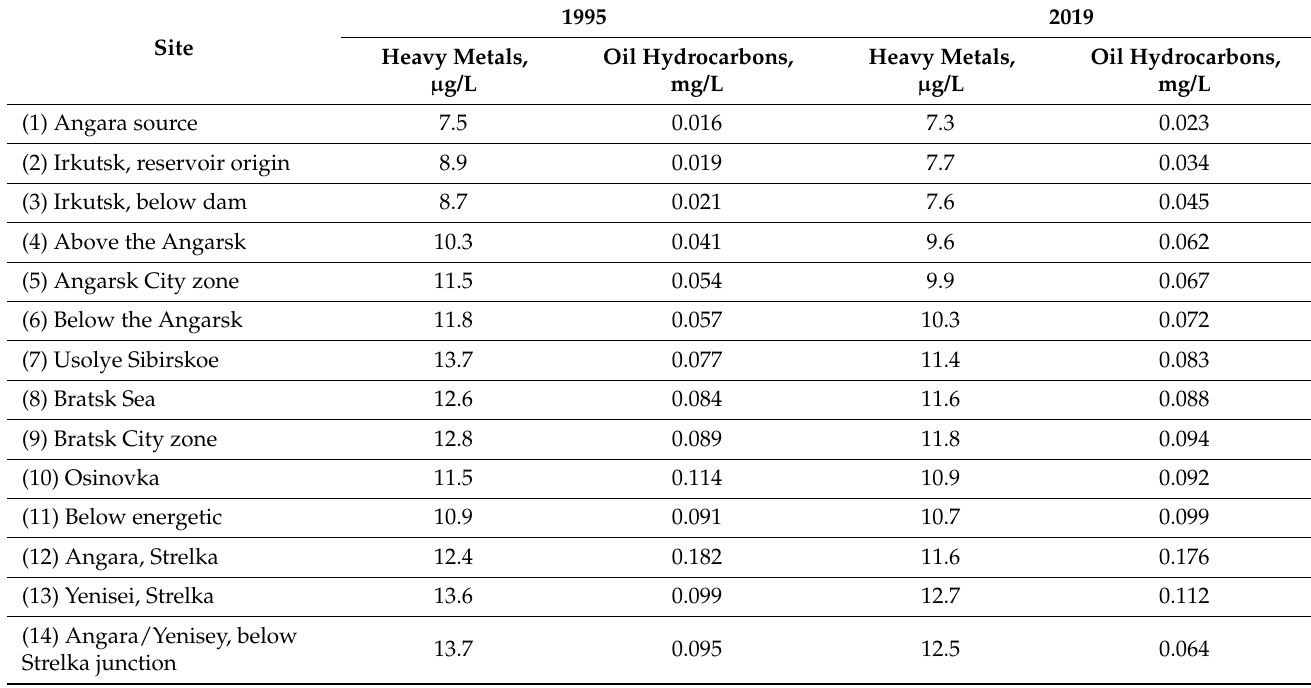
Table 5. Comparison of concentrations of heavy metals and oil hydrocarbons in the Angara/Yenisei River system carried out in 1995 and